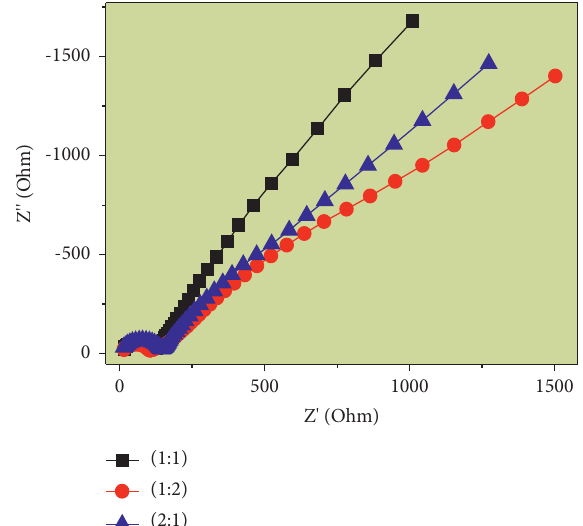
Figure 8: EIS spectra of green-synthesized Co